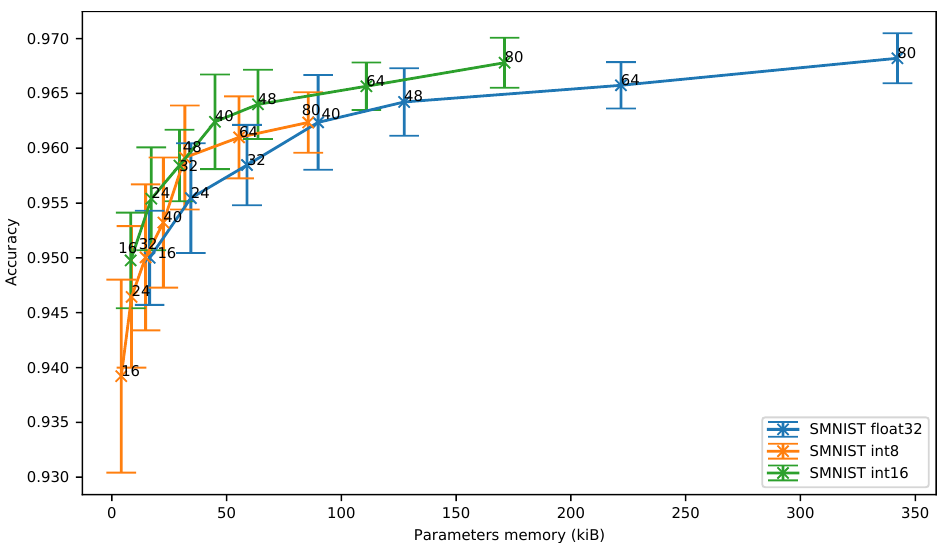
Figure 8. Spoken digits dataset (SMNIST): accuracy vs. parameters